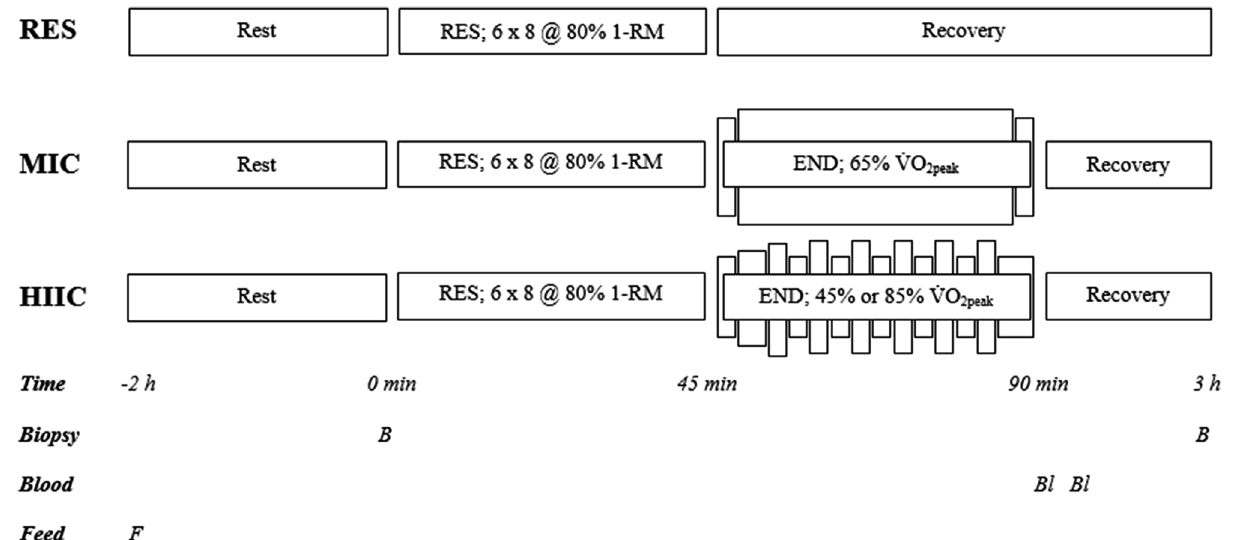
Figure 4. Schematic of the experimental and sampling timeline. RES resistance exercise; END endurance